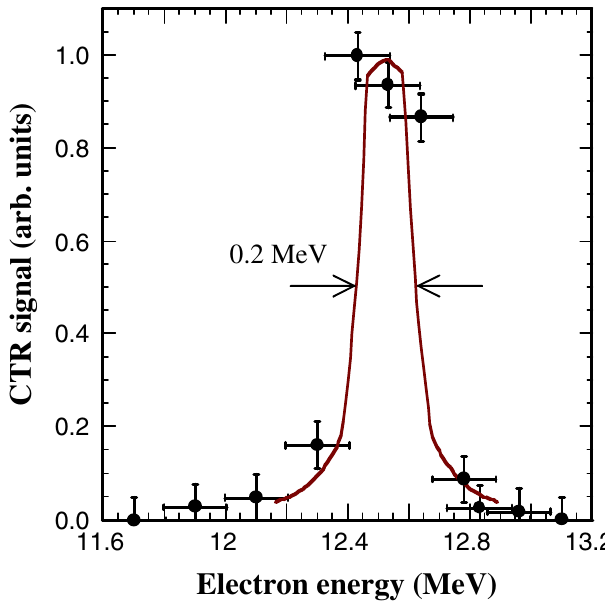
FIG. 3. (Color) Fundamental 10 - (cid:1) m CTR signal (circles) and the calculated normalized bunching factor (solid line) as a function of the electron beam energy.